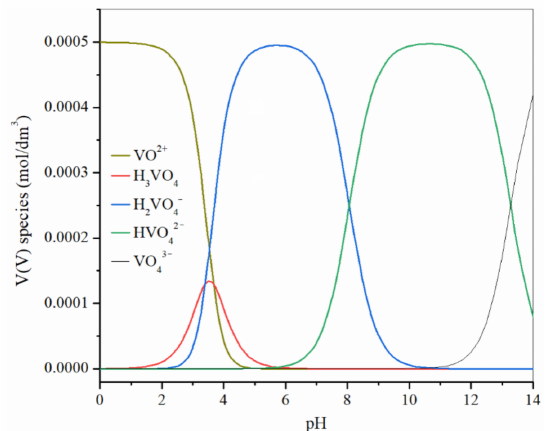
Figure 6. Distribution of vanadium (V) species as a function of pH (Ionic strength: 0.01 M; total vanadium concentration: 0.5 mM).